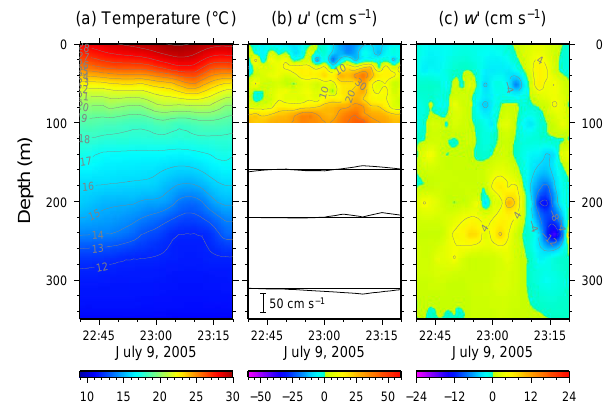
Fig. 2. The left (a) , middle (b) , and right (c) panels represent the contours of isotherms, perturbations of the eastward current component ( u 0 ), and vertical current component ( w 0 ) as functions of time and depth, respectively, from 23:20 to 24:00UTC on 27 June 2005. The temperature data were measured by 16 temperature sensors at depths from 32 to 338m. The eastward current data were measured by an ADCP between 15m and 95m and three RCM8s at 160m, 220m, and 310m. The contour intervals are 1 ◦ C, 10cms − 1 , and 4cms − 1 for temperature, u 0 , and w 0 , respectively. Positive u 0 and w 0 indicate eastward and upward velocities, respectively.